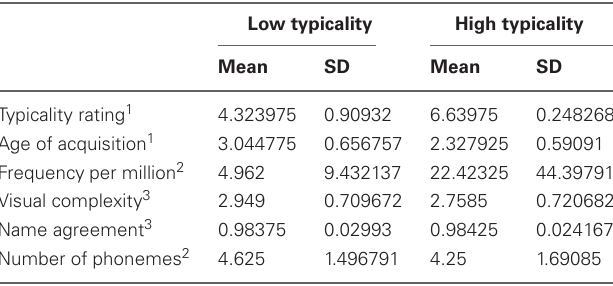
revealed significant main effects of frequency ( F ( 1 , 66 ) = 5 .